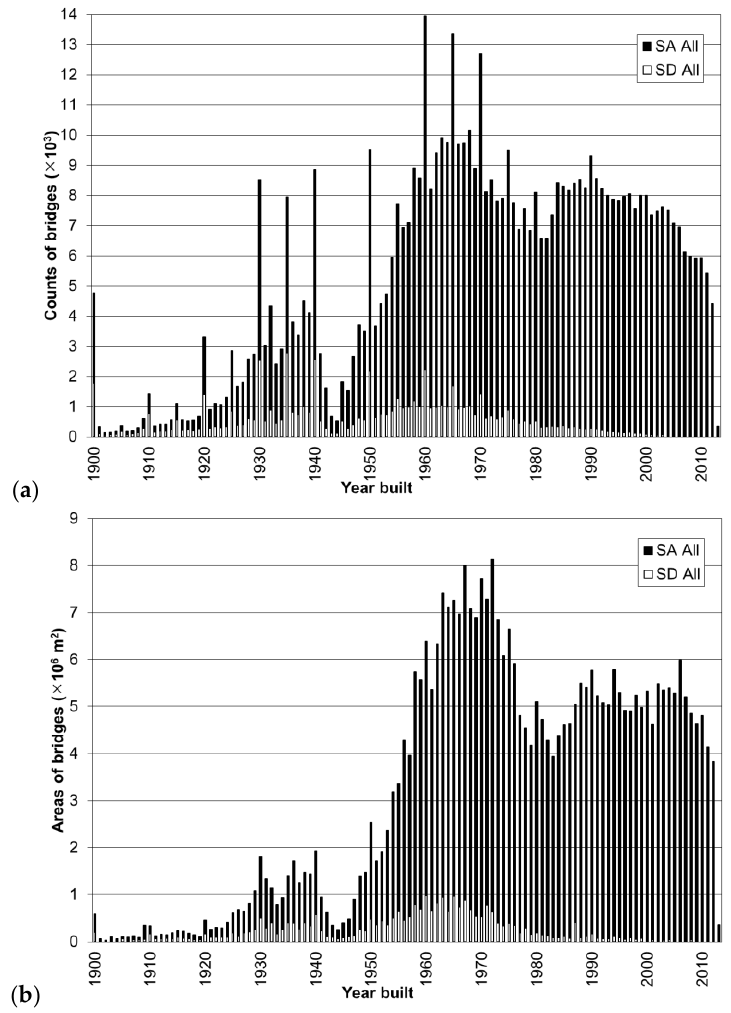
Figure 8. Distribution and SA to SD ratio of all bridges. (a) Counts and (b) Areas.